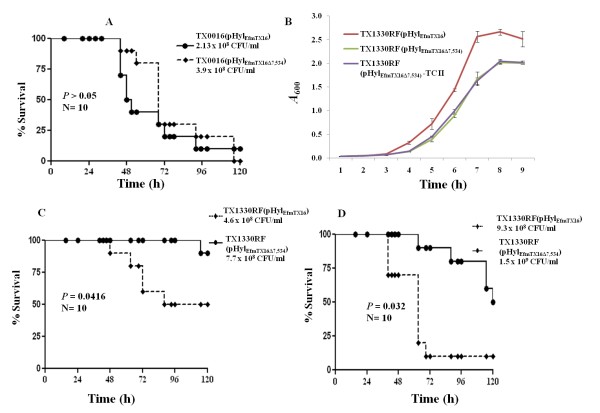
Growth and survival curves in the mouse peritonitis model of E. faecium TX0016(pHylEfmTX16) and TX1330RF(pHylEfmTX16), carrying an intact hylEfm-region, and pHylEfmTX16Δ7,534 (6 gene mutant of the hylEfm-region). A, Survival curve of representative inoculum (5 inocula per experiment in two independent experiments) of TX0016(pHylEfmTX16) vs TX0016(pHylEfmTX16Δ7,534) in mouse peritonitis; B, growth curves of TX1330RF(pHylEfmTX16) vs TX1330RF(pHylEfmTX16Δ7,534) and a second transconjugant [TX1330RF(pHylEfmTX16Δ7,534)-TCII] obtained from the same mating experiment between TX16(pHylEfmTX16Δ7,534) and TX1330RF, expressed as optical density (A600) in brain heart infusion (BHI) broth (results of at least three experiments per strain). C and D, survival curves of TX1330RF(pHylEfmTX16) vs TX1330RF(pHylEfmTX16Δ7,534) obtained in the peritonitis model at different inocula in independent experiments performed at different days.